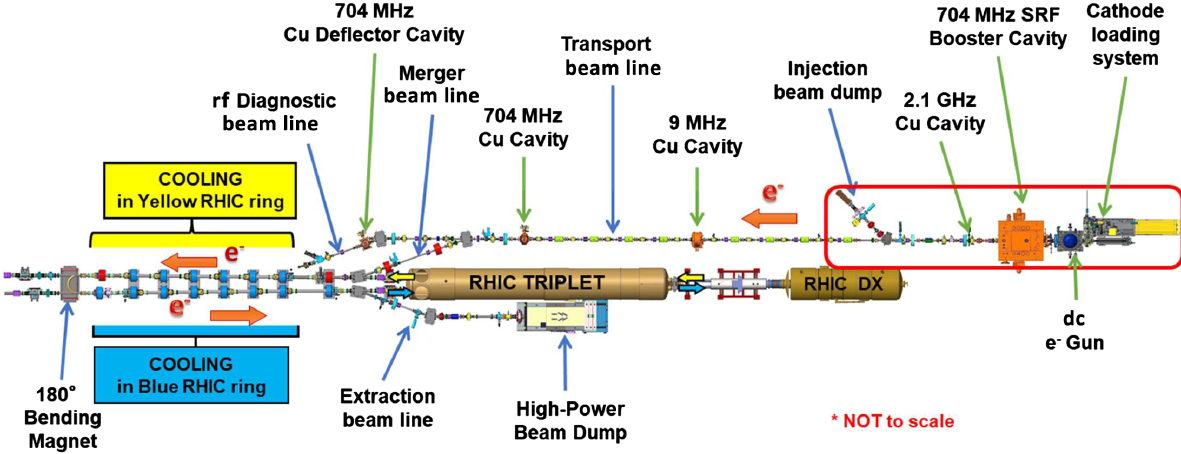
1. Layout of the LEReC accelerator. The red contour box indicates the dc gun test